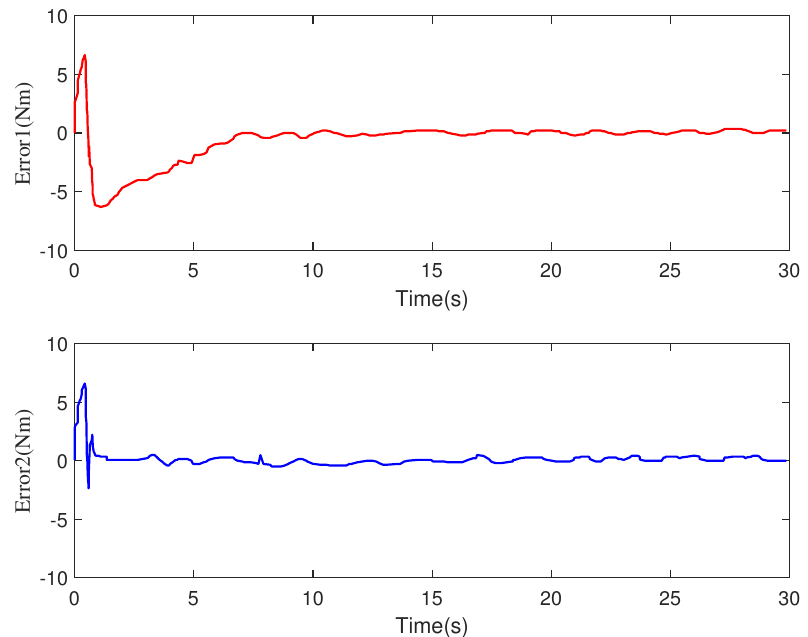
Figure 13. Uncertainties estimation errors with time-varying external disturbances in Case 3 for the 2-DOF robot